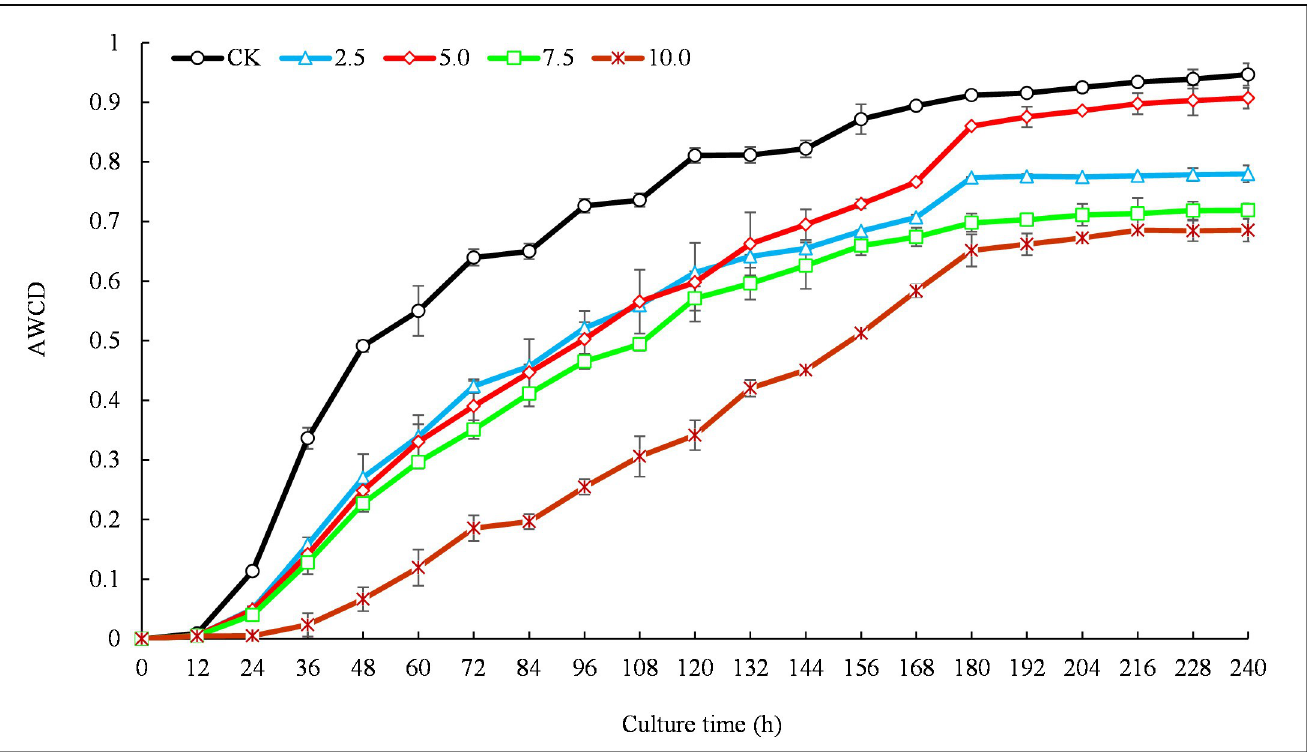
Fig 2. Variation in average well color development (AWCD) of soil microbes at different R . typhina root extract concentration over time. CK, 2.5, 5, 7.5, 10 represent different extract concentrations of 0, 2.5, 5, 7.5, 10 mg � mL -1 , respectively. Values represent means ± standard deviation.